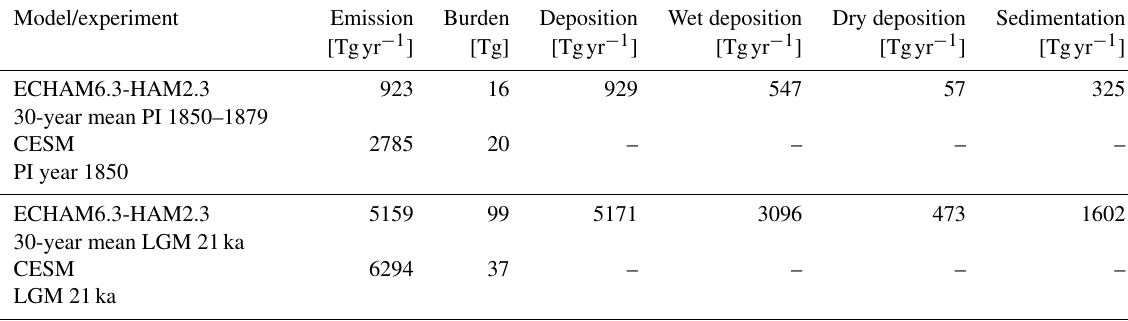
Table 2. Key values for dust emission, burden, and deposition characterizing the global dust cycle budget as simulated by our model ECHAM6.3-HAM2.3 compared to results obtained with CESM (Albani and Mahowald, 2019).